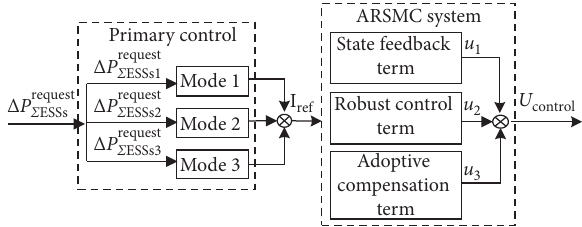
Figure 5: The control system of the ESS in ESS-integrated PV/wind